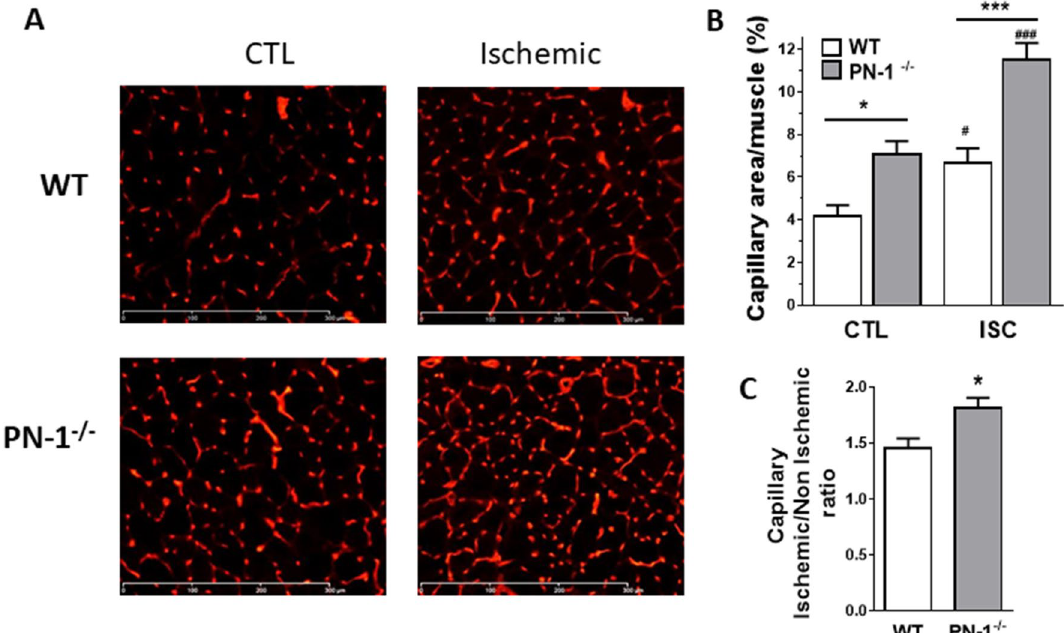
Figure 3. PN-1 deficiency results in higher capillary density in normal and ischemic muscle. ( A ) Capillaries were visualized by Isolectin B4 staining of control (CTL) and ischemic muscles from WT and PN-1 −/− mice 7 days after surgery. Representative images are shown. ( B ) Capillary density was quantified as the percentage of area covered by vessels (n ≥ 7). Statistical analysis was performed using Anova. ( C ) Ratio of capillary density of ischemic to non-ischemic muscles was calculated for each mouse (n = 7); t test: * p < 0.05; *** or ### p < 0.001; *: KO versus WT and #: ischemic versus